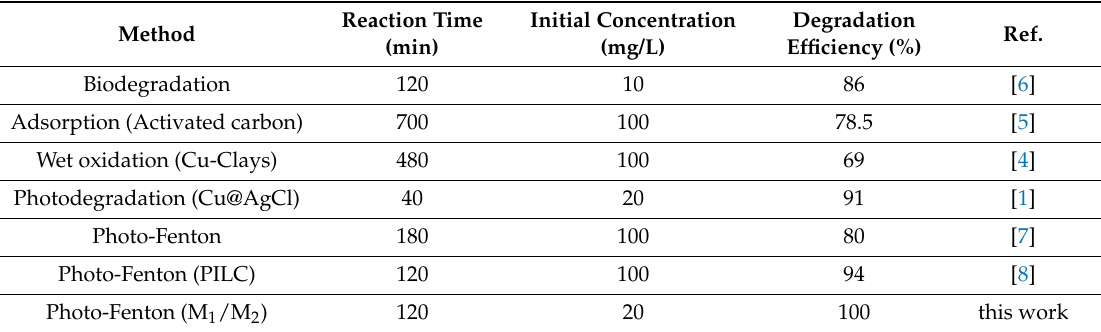
Table 5. Comparison of degradation efficiency and times for different